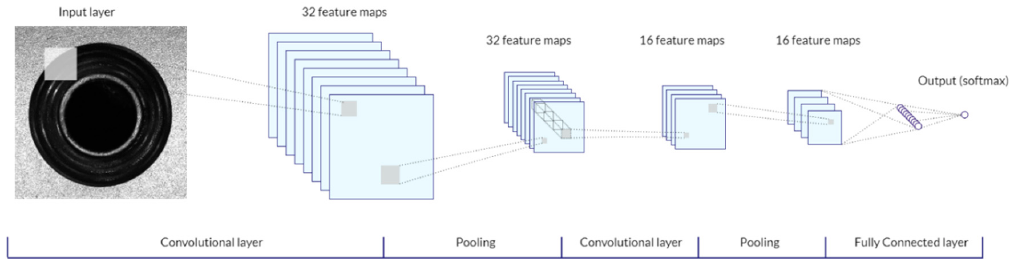
Figure 7. Architecture of the developed neural network.